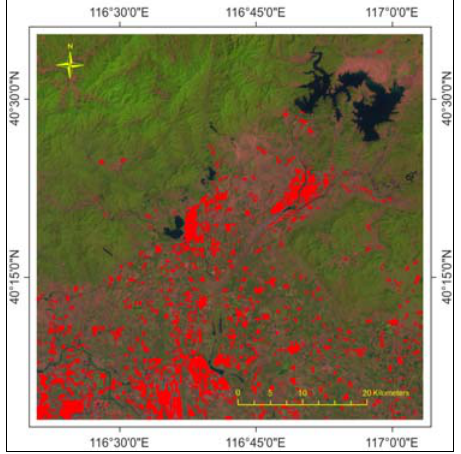
Figure 6. Spatial distribution of the continuous pattern “111111” (in red) Considering the discontinuous pattern “442444” as an example, the support of the pattern is 0.17% and its spatial distribution is shown in Figure 7.